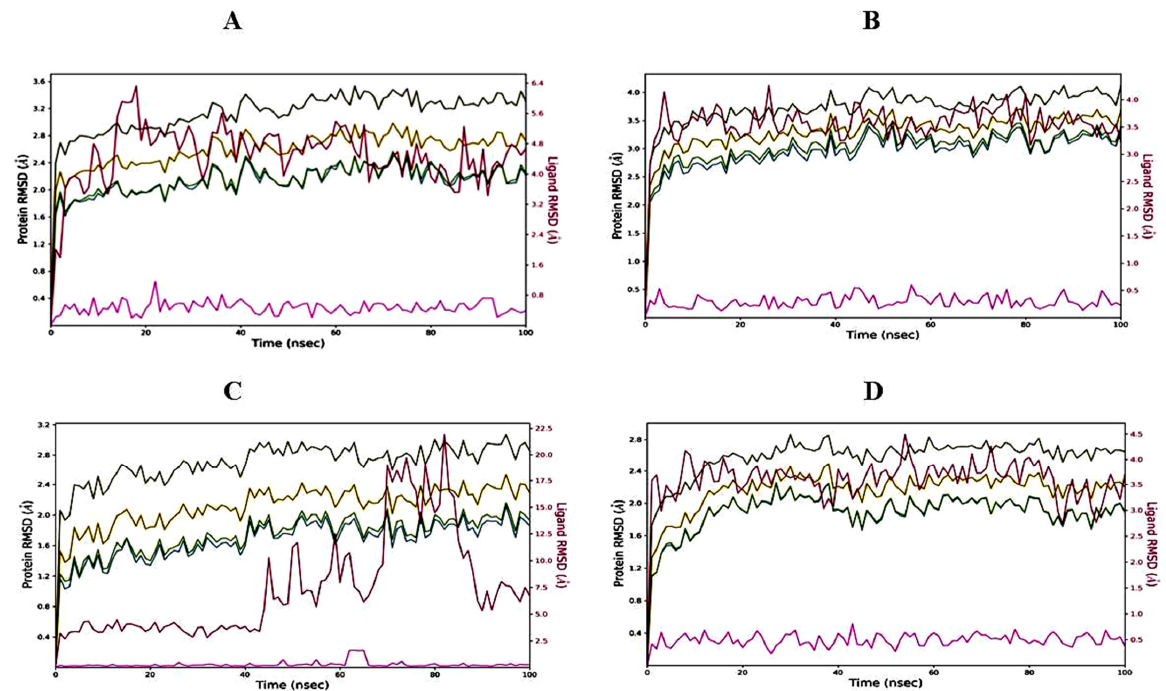
Figure 4. RMSD graph of 3,7-cyclodecadien-1-one, 3,7-dimethyl-10-(1-methylethylidene) of CLO with target proteins. ( A ) 3,7-cyclodecadien-1-one, 3,7-dimethyl-10-(1-methylethylidene) in complex with 1EA1; ( B ) 3,7-cyclodecadien-1-one, 3,7-dimethyl-10-(1-methylethylidene) in complex with 1IYL; ( C ) 3,7-cyclodecadien-1-one, 3,7-dimethyl-10-(1-methylethylidene) in complex with 1HD2; ( D ) 3,7-cyclodecadien-1-one, 3,7-dimethyl-10-(1-methylethylidene) in complex with 1HNY protein. Color legends: Ca (blue color), side chains (green color), heavy atoms (yellow color), ligand with protein (dark pink color), ligand with ligand (pink color).